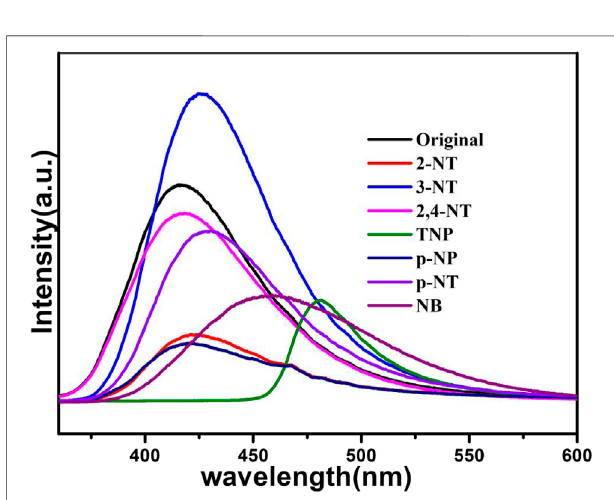
FIGURE 9 | Fluorescence of 1a in DMA containing different volumes of Cr 3+ (5 × 10 – 3 M).